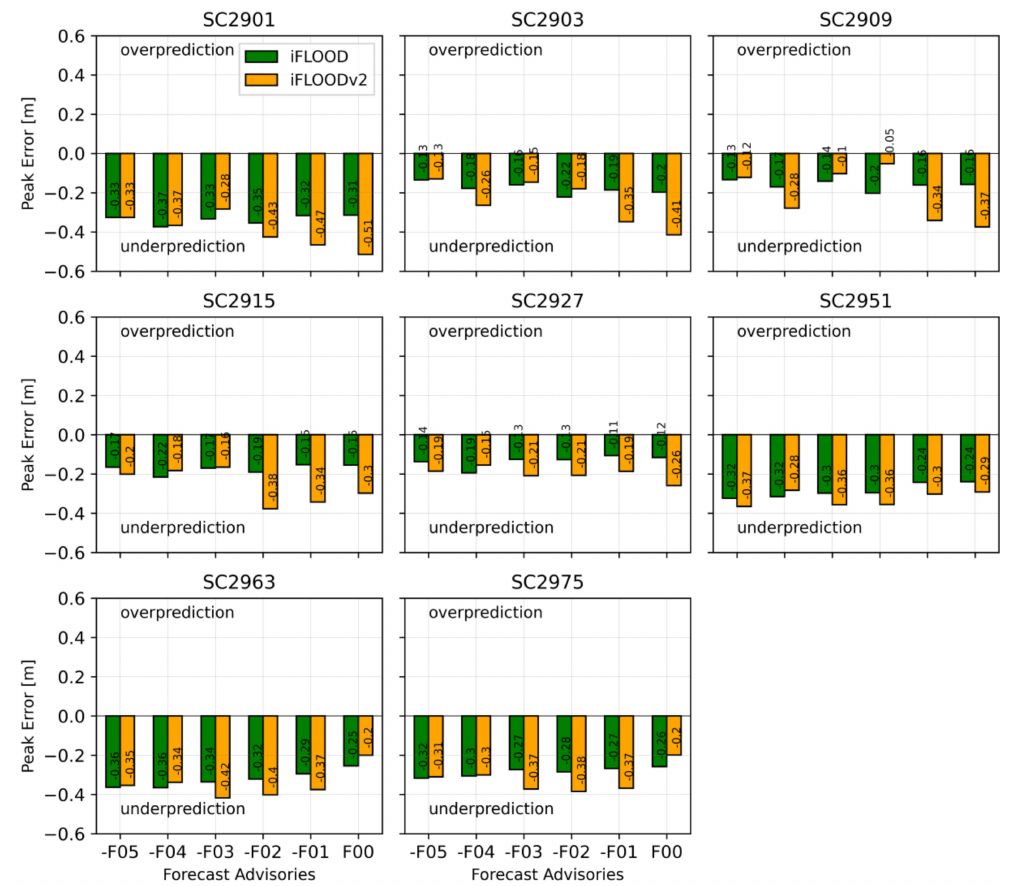
Figure 9. Bar plots of peak errors for maximum water levels at 8 wave recording stations during the bomb cyclone of 2020. F00 represents the forecast advisory on 1 July at 18:00 UTC, while the bars before F00 represent the forecasts issued earlier at 12 h intervals.